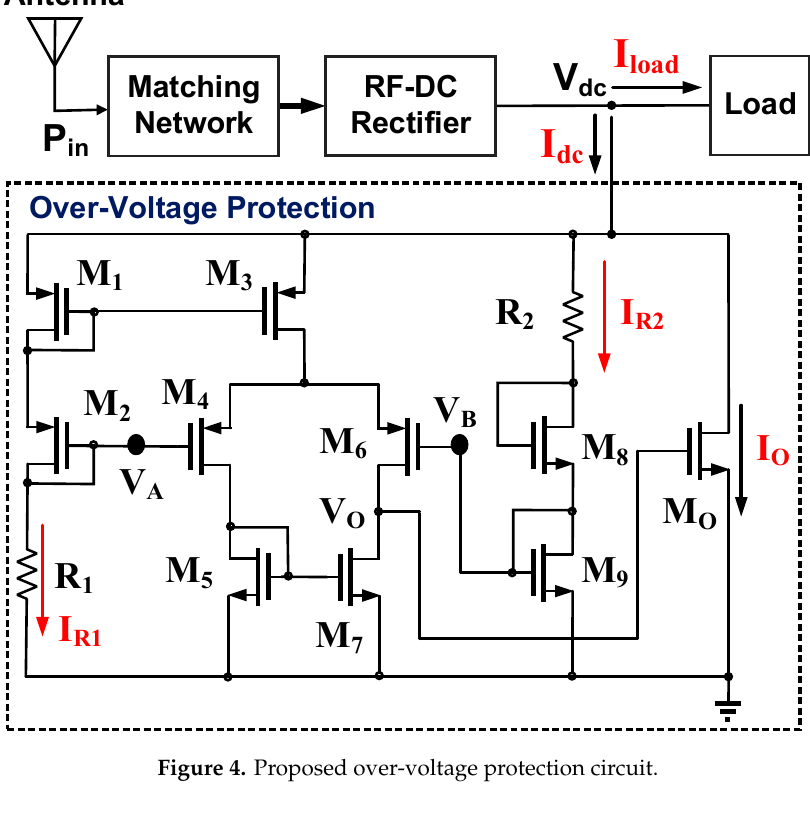
Figure 4. Proposed over-voltage protection circuit.